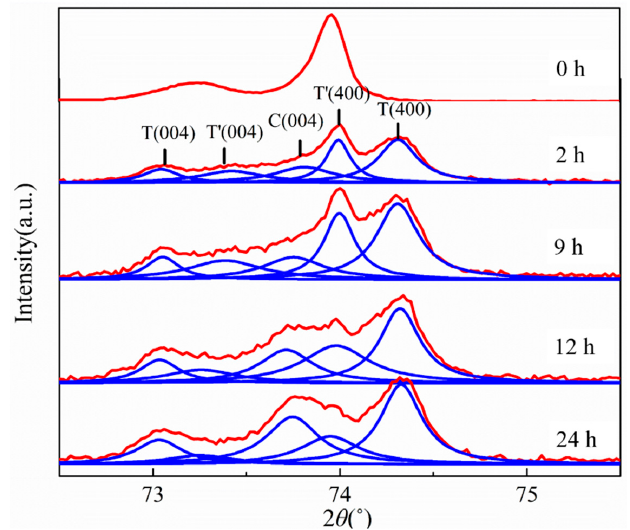
Figure 5. The evolution of XRD patterns and five diffraction peaks of C (004), T (004), T (400), T ′ (004) and T ′ (400) by Lorentz peak fitting (R 2 > 0.99).